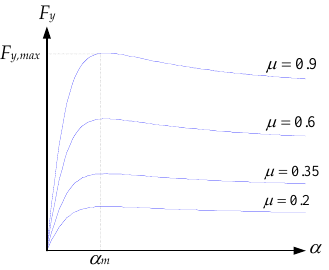
Figure 3. Lateral tire force with respect to slip angle.